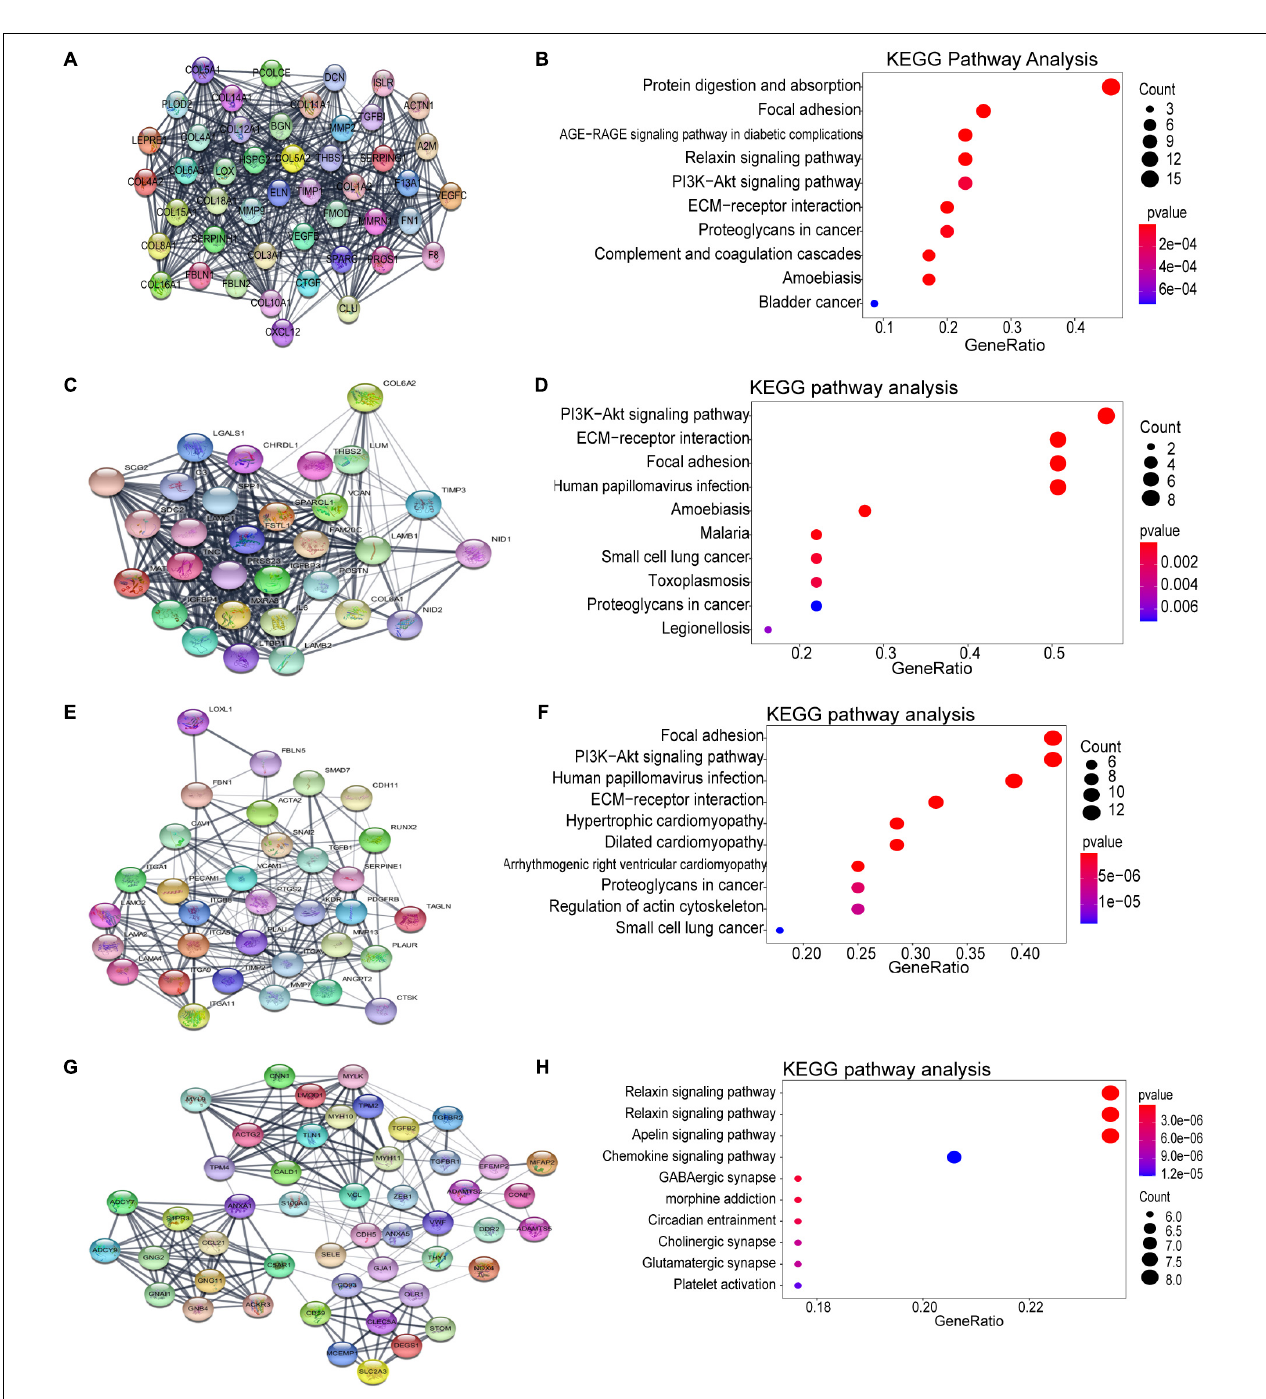
FIGURE 5 | Identification of the top four modules (159 genes in total) and correlated pathways from the PPI network. (A,B) Module 1 (47 genes) and its top 10 enriched KEGG pathways. (C,D) Module 2 (30 genes) and its top 10 enriched KEGG pathways. (E,F) Module 3 (33 genes) and its top 10 enriched KEGG pathways. (G,H) Module 4 (49 genes) and its top 10 enriched KEGG